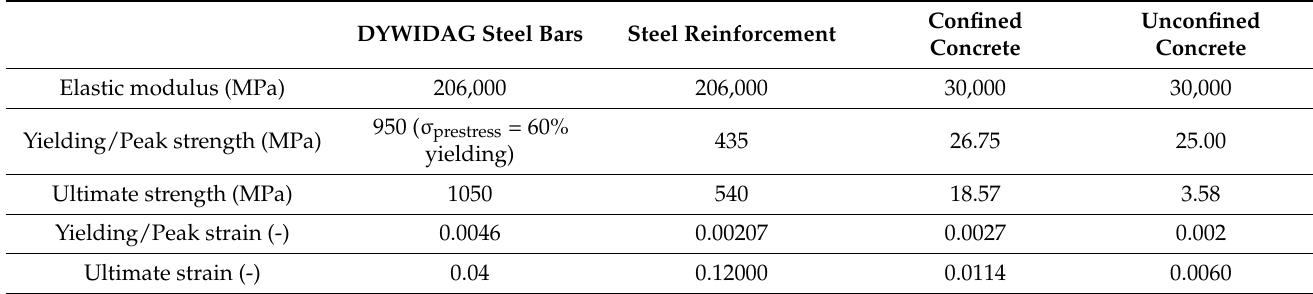
Table 2. Steel and concrete mechanical